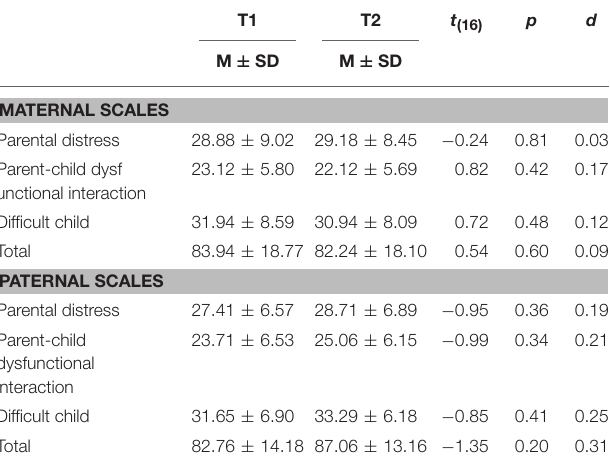
TABLE 2 | Means, SDs of PSI-SF at T1 and T2, and tests for differences.